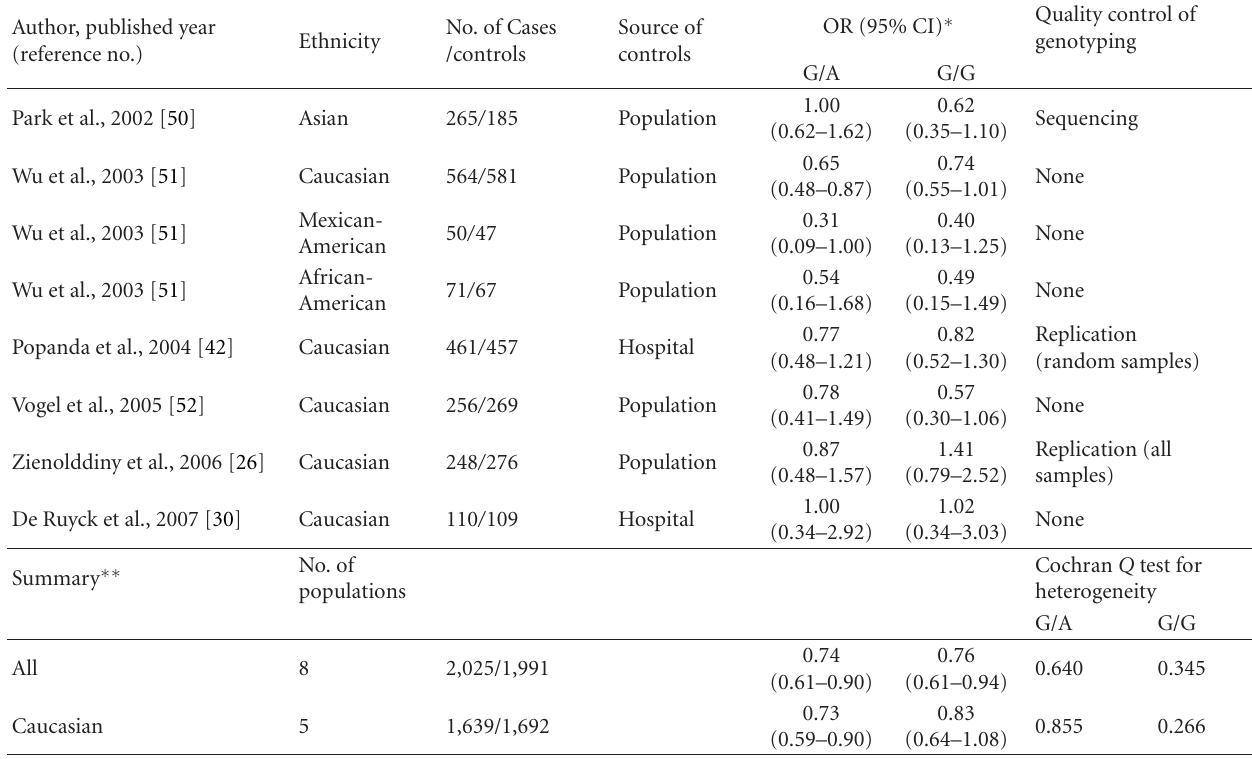
Table 6: Genetic polymorphisms in the NER pathway and lung cancer risk: XPA G23A